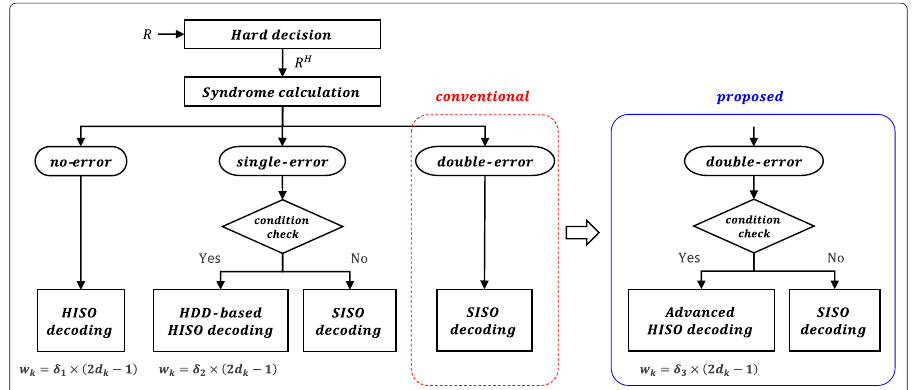
Fig. 1 A block diagram illustrating the main concept of the proposed syndrome-based decoding algorithm. The red box represents the conventional decoding technique (SISO decoding) when the double-error syndrome is detected, and we want to modify it like the blue box (a combination of advanced HISO and SISO